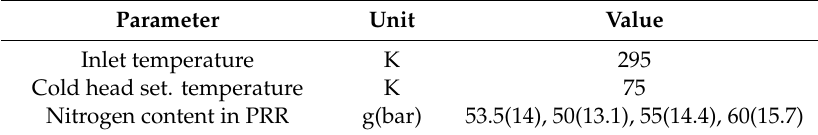
Figure 6. Experiment setup for heat-transfer characteristic of the CLHP: ( a ) device setup for the experiment; ( b ) the CLHP installation in the space environment simulator. Table 7. Experiment conditions for determining the heat-transfer characteristics of the CLHP.